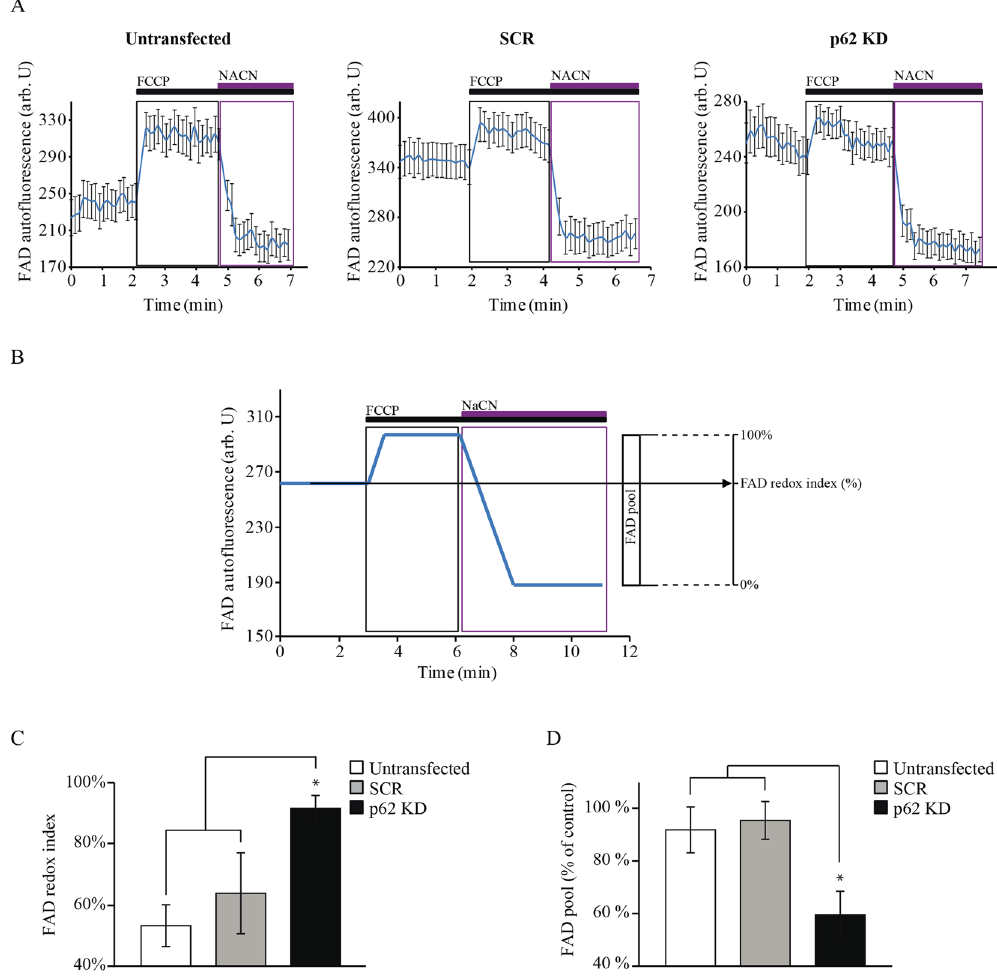
Figure 3. Altered FAD homeostasis is reflected in p62 deficient cells. ( A ) Time-course representative traces of FAD autofluorescence from untransfected, SCR and p62 KD SH-SY5Y cells. Addition of FCCP (1 μ M) maximised respiration and thereby increased FAD autofluorescence to maximal levels (100%). Addition of NaCN (1 mM) then inhibited respiration and reduced the FAD autofluorescence to a minimum (0%). The traces represent the mean of at least 20 cells on a single coverslip ± SEM. ( B ) Graphical description of the FAD homeostasis analysis by monitoring the FAD autofluorescence using confocal microscopy in p62 deficient cells compared to controls. FAD redox indexes were obtained by calculating the initial FAD autofluorescence when the minimum FAD autofluorescence is normalised to 0% and the maximum to 100%. The FAD redox index generation (the initial redox level expressed as percentage of the range) and the FAD pool are described graphically. ( C ) FAD redox indexes from untransfected, SCR and p62 KD SH-SY5Y cells representing the mean of at least 3 independent experiments ± SEM. In all cases * indicates p < 0.05 compared with the values in the corresponding control cells. ( D ) The FAD pool was expressed as absolute values between maximal and minimal respiration in untransfected, SCR and p62 KD SH-SY5Y cells. Data represent the mean of at least 3 independent experiments ± SEM. * indicates p < 0.05 compared with the values in the corresponding control